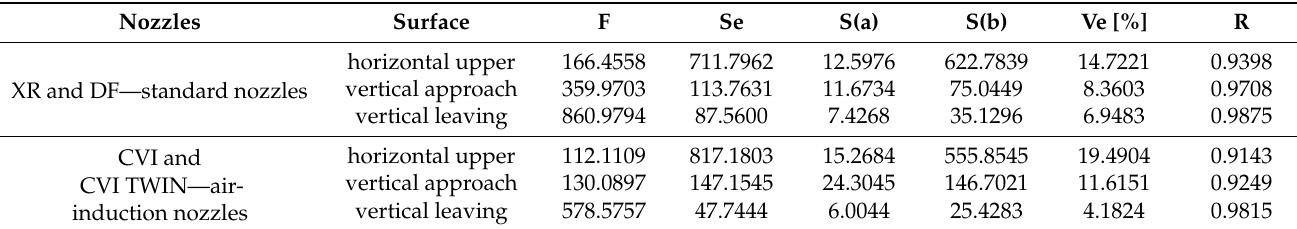
Table 3. The analysis of